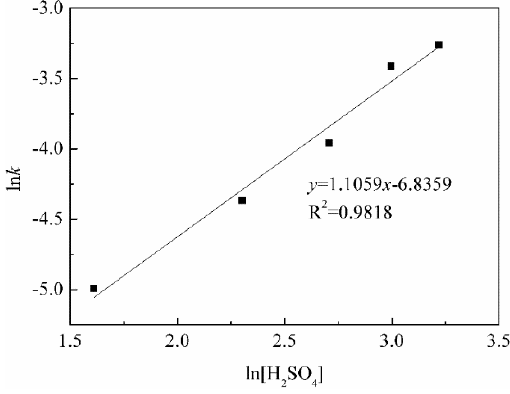
Figure 18. Fitting plot of ln k as a function of ln[H 2 SO 4 ].